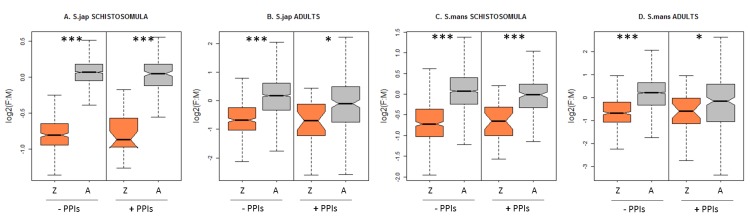
Z-linked and autosomal female:male ratio of gene expression according to presence/absence of known protein-protein interactions.The Z-linked and autosomal gene expression patterns are shown for schistosomula and adults, in S. japonicum (A–B) and S. mansoni (C–D). We considered only genes with minimum level of expression RPKM >1 in all stages, did not take into account the ancestral state of expression, and used the ‘exhaustive strata’ set of genes. -PPIs and +PPIs refer to the female:male ratio of expression in the lineage-specific Z-linked strata S1jap and S1mans, respectively. The level of significance of each comparison is denoted with asterisks: ***p-value<0.0001.